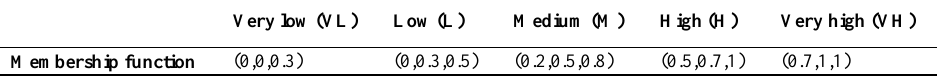
Table 1. Linguistic terms for importance weight of each criterion.